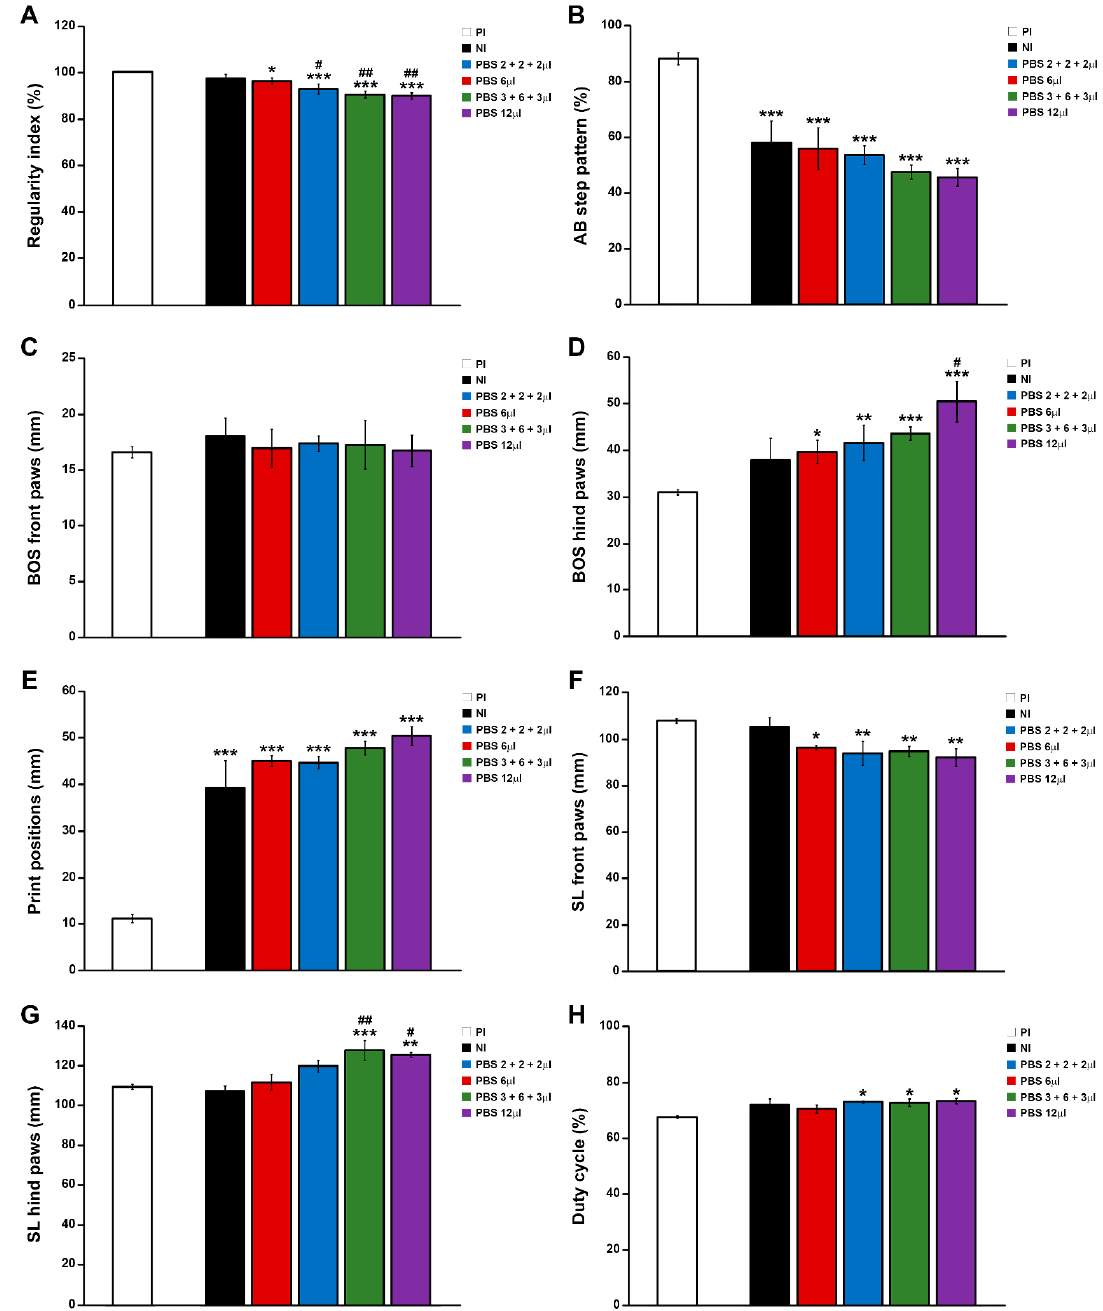
Figure 3. Determination of the injection system: Catwalk ® -based gait analysis I. Graphs present data obtained from the evaluation at 42 days post-injury of motor functional recovery using the Catwalk ® gait analysis system [non-injected (NI) group vs. PBS-injected groups (PBS 6 µ L, PBS 2 + 2 + 2 µ L, PBS 3 + 6 + 3 µ L, or PBS 12 µ L)] in the experimental set performed to determine the best (EIS) 2 -RGD6 injection system [experiment (EIS) 2 -RGD6 I]. The following gait parameters were evaluated: ( A ) regularity index; ( B ) AB step pattern; ( C ) front paws base of support (BOS); ( D ) hind paws BOS; ( E ) print positions; ( F ) front paws stride length (SL); ( G ) hind paws SL; and ( H ) duty cycle. In ( A – H ), the potential existence of statistically significant between-group differences was assessed by one-way ANOVA followed by the Bonferroni post-hoc test. In all cases: *, p < 0.05; **, p < 0.01; and *** p < 0.001 vs. pre-injury (PI), while #, p < 0.05 and ##, p < 0.01 vs.